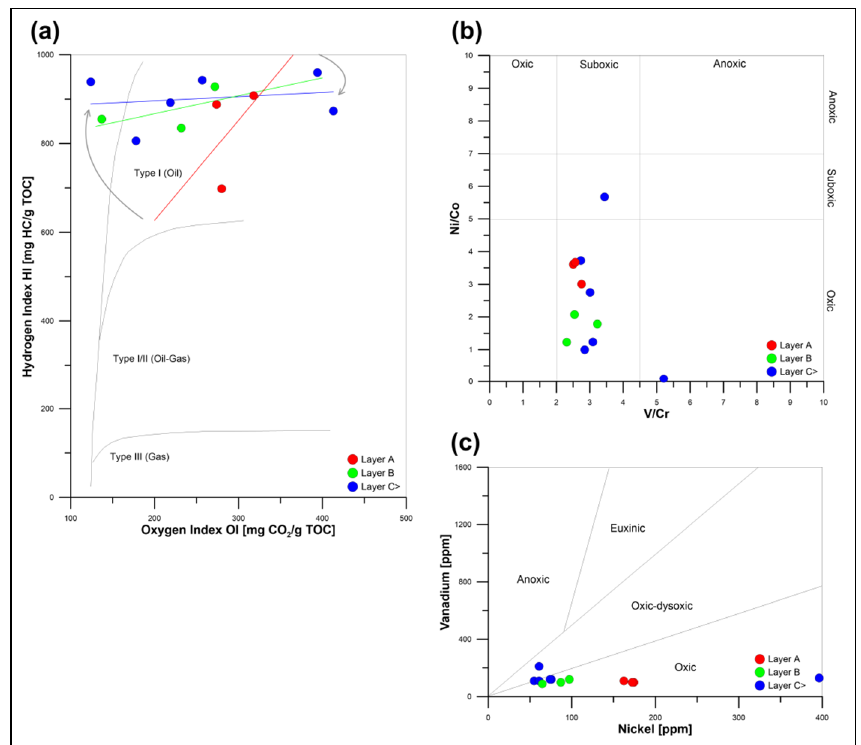
Figure 6. The pseudo-van Krevelen and environmental diagrams of analysed samples: ( a ) HI versus OI showing rotational variability (black arrows) of kerogen type highly related to sediment burial depth; ( b ) Ni/Co and V/Cr as environmental indicators of oxic to suboxic conditions; ( c ) the V and Ni relations indicate a transition between oxic and oxic–dysoxic conditions; the oxic conditions are typical for “layer A” (active layer), being reduced rapidly with burial depth; ( b ) and ( c ) follow [56].